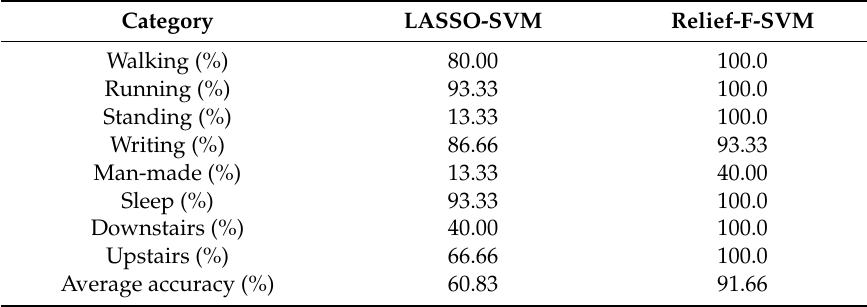
Figure 6. 10 ‐ fold cross ‐ validation of polynomial kernel optimization. Figure 6. 10-fold cross-validation of polynomial kernel optimization. Table 4. Classification e ff ect of di ff erent feature selection methods (Polynomial). LASSO: least absolute Table 4. Classification effect of different feature selection methods (Polynomial). LASSO: least shrinkage and selection absolute shrinkage and selection operator.